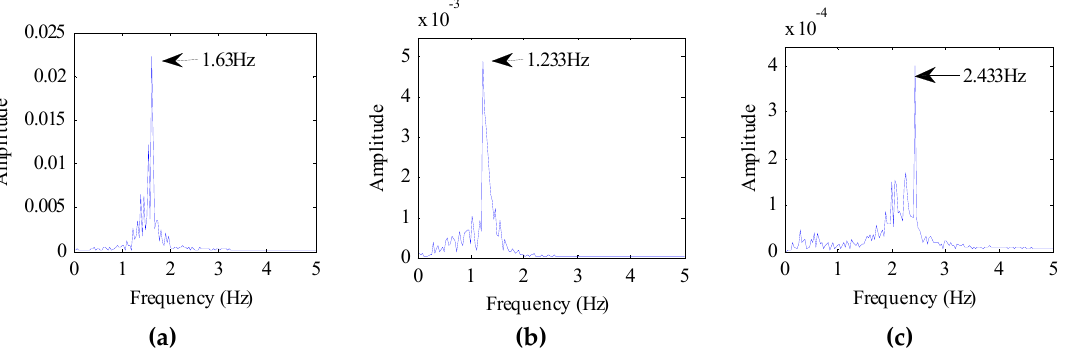
Figure 10. Frequency of target heartbeat. ( a ) Target is 1 m away from the radar; ( b ) Target is 2 m away from the radar; ( c ) Target is 3 m away from the radar.